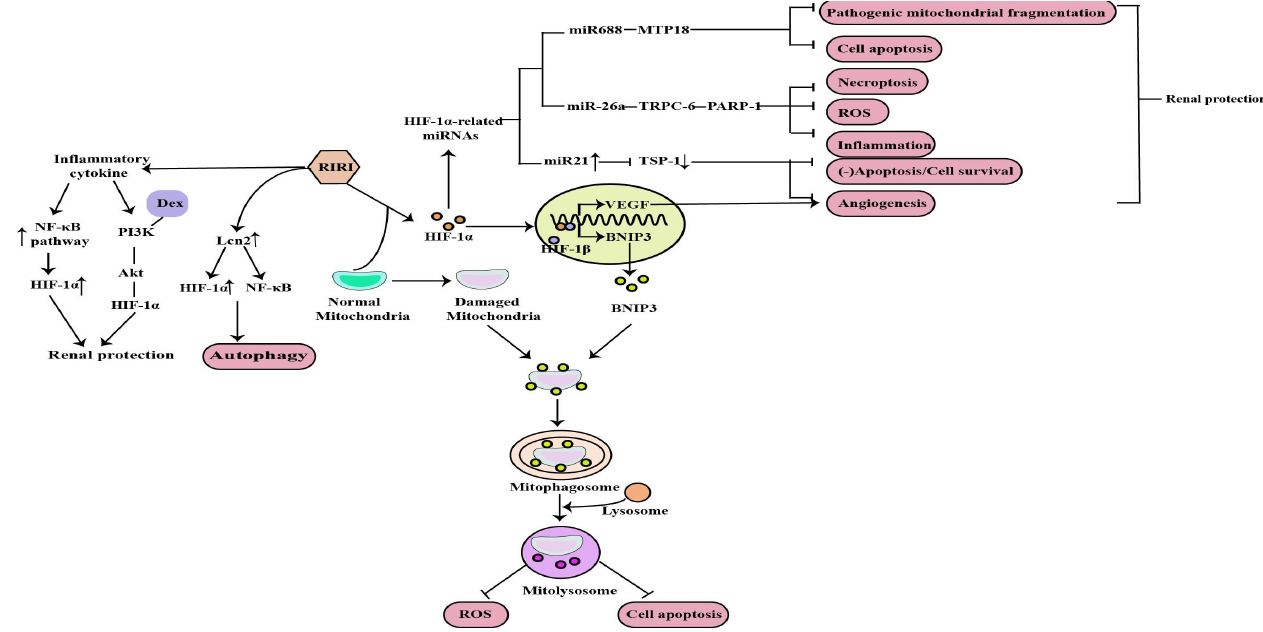
Figure 2. Mitochondrial dysfunction, induction of inflammation, apoptosis, autophagy, necroptosis, angiogenesis and ROS are the major factors in the pathogenesis of RIRI, and HIF − 1 α can protect against the kidney injury caused by RIRI through the above mechanisms ( ↑ : elevated expression; ↓ : decreased expression).